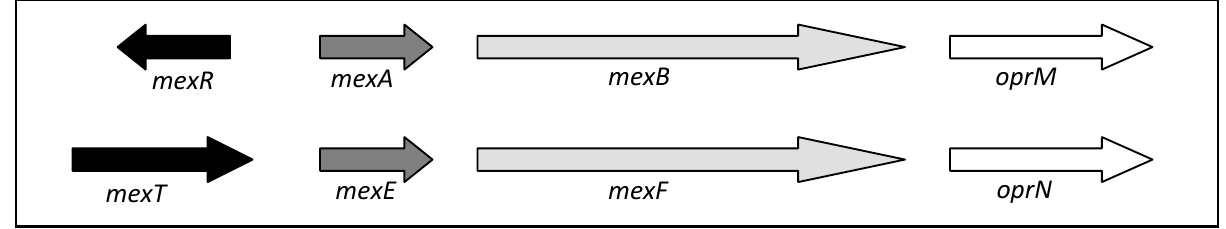
Figura 3 – Contexto genético de genes codificadores de proteínas constituintes dos sistemas de efluxo MexAB-OprM e MexEF-OprN em P. aeruginosa Cada operon contém os genes que codificam os componentes dos sistemas de efluxo: regulador transcricional (preto) e proteínas de membrana interna (cinza claro), periplas- mática (cinza escuro) e de membrana externa (branco). Ambos os sistemas são responsáveis por fenótipos carbapenem-resistentes na espécie estudada. Adaptada de Lister et al.